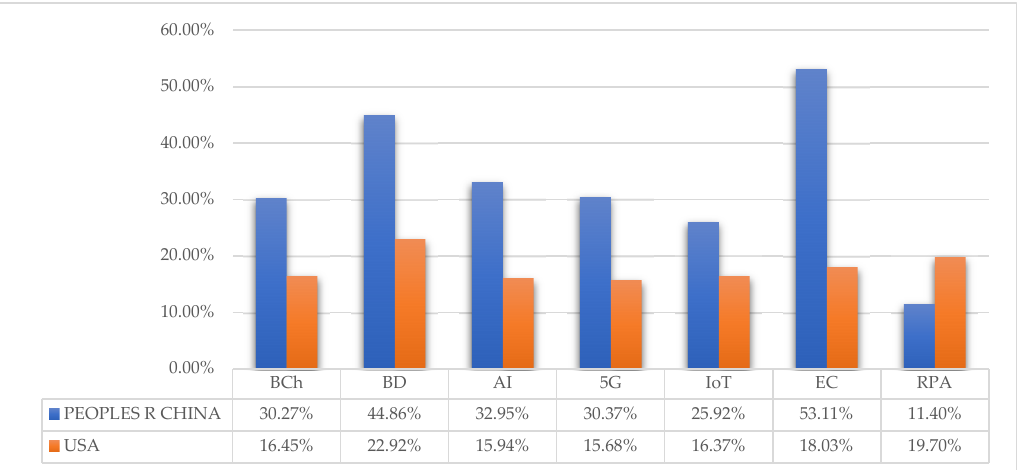
Figure 4. Publications analysis on emerging technologies from 2013 to 2021.